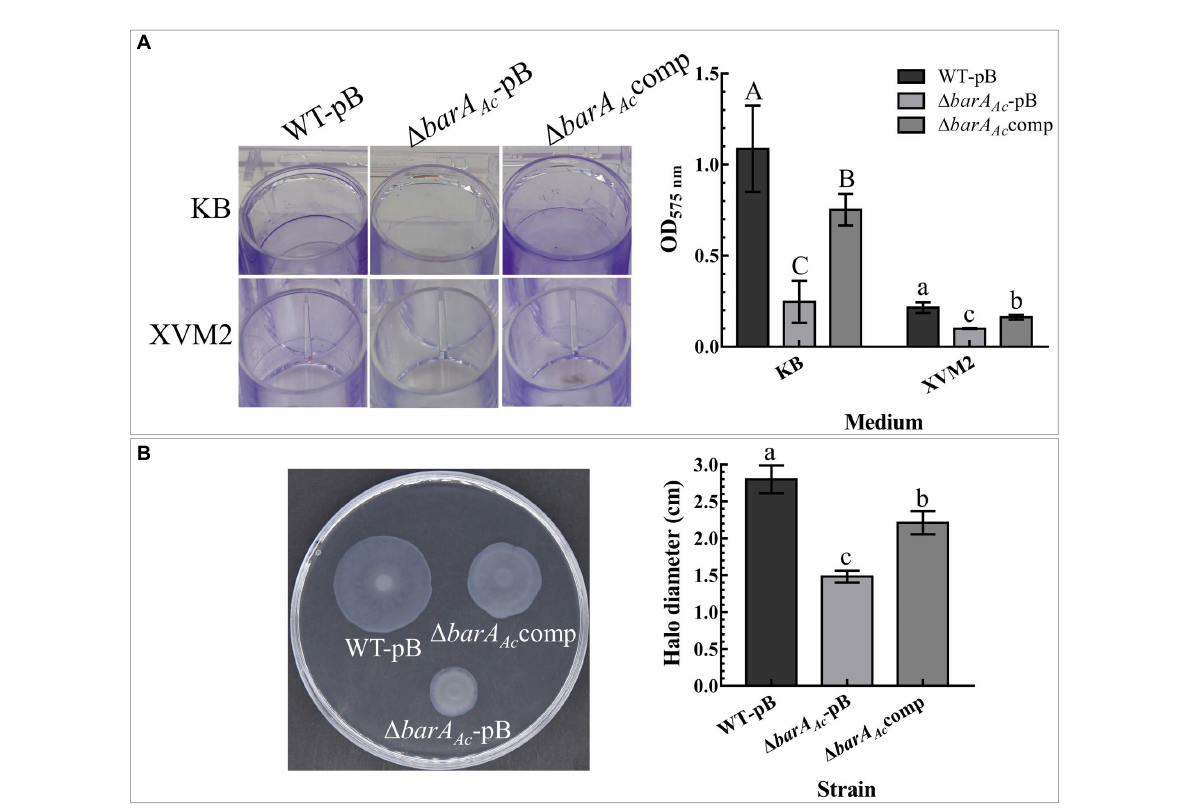
FIGURE 3 Effects of barA Ac on biofilm formation, and swimming motility in Acidovorax citrulli . (A) Biofilms formed by WT-pB, Δ barA Ac -pB, and Δ barA Ac comp cultured on polystyrene plates in KB and XVM2 media for 72 h. XVM2 medium served as a medium to simulate the plant environment. The bar chart shows the average OD 575 absorbance measured after the biofilm was dissolved in 95% ethanol. Each treatment was replicated 6 times. The error bar represents the standard deviation. Different uppercase letters on top of the bar indicate strains with significant differences in biofilm formation ability in KB medium, and different lowercase letters on top of the bar indicate strains with significant differences in biofilm formation ability in XVM2 medium, respectively (ANOVA, p < 0.05). (B) The swimming motility of WT-pB, Δ barA Ac -pB, and Δ barA Ac comp incubated in 0.3% water agar medium for 48 h. The bar chart shows the average halo diameter of the tested strains. Each treatment was replicated 5 times. The error bar represents the standard deviation, and different lowercase letters on top of the bar indicate significant differences (ANOVA, p <